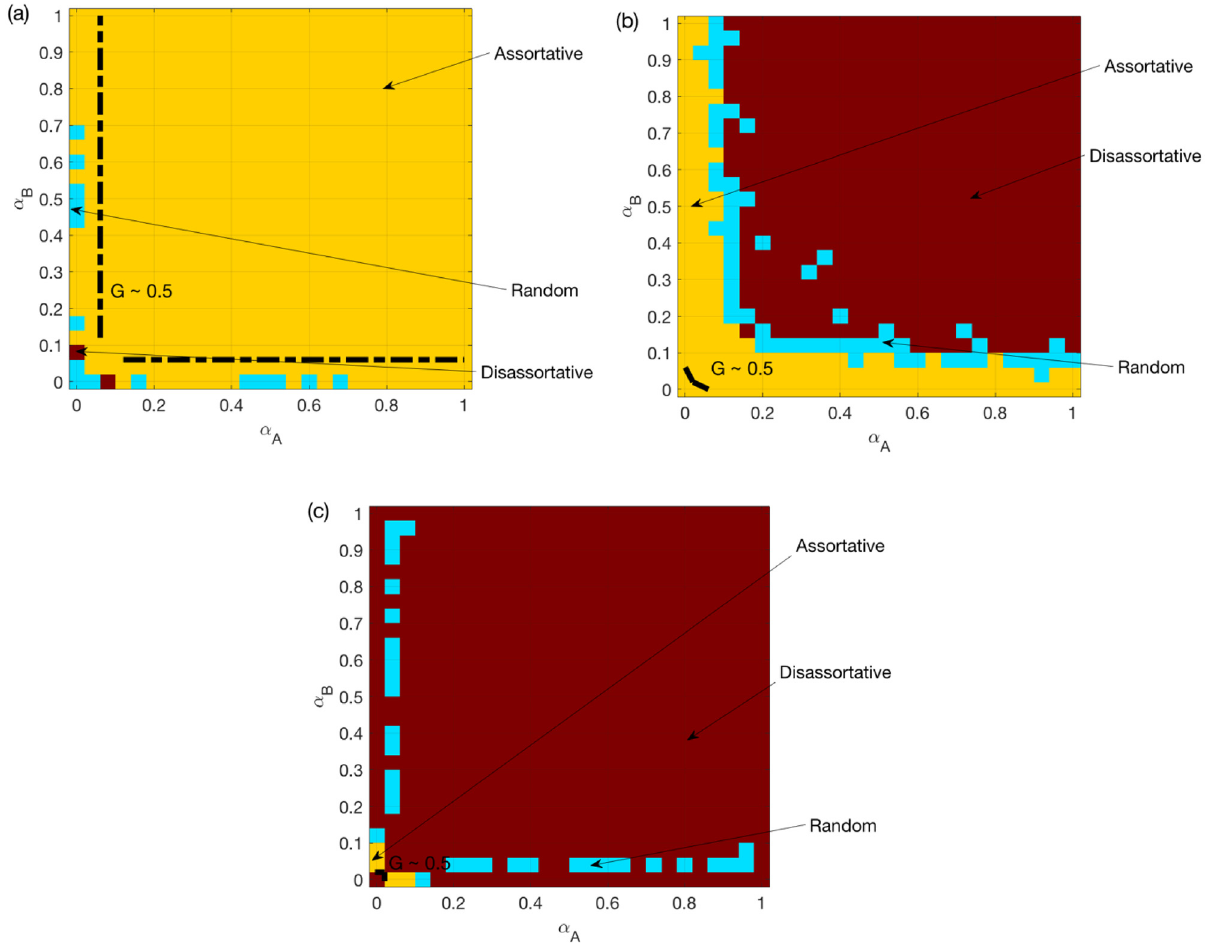
Fig 2. Best choice among random/assortative/disassortativecoupling schemes for two ER networks. (a) OR rule. (b) SUM rule. (c) AND rule. N = 500, k A = k B = 6, averagedover M = 50 realizations. The color for certain α A and α B values indicatesthe couplingscheme with the largest mean G value. Since the largest mean G value (among the three couplingschemes) increasesin generalfor larger α A and α B , a dashed line is addedto each sub-figure to indicate the locationwhere the best mean G reaches0.5.